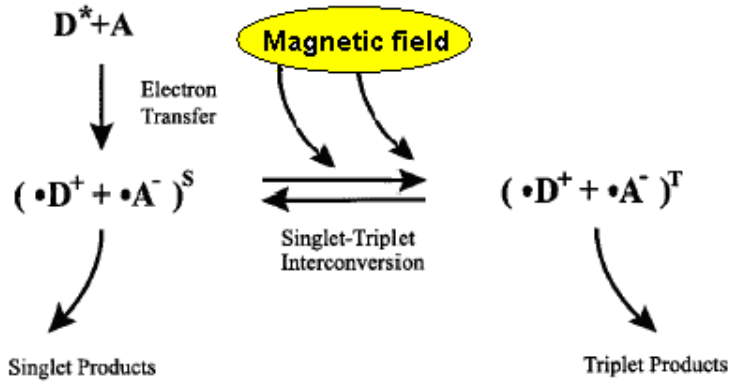
Figure 3. Reaction scheme for a radical pair reaction with magnetic field-dependent reaction products. The radical pair is generated by an electron transfer from a donor molecule D to an acceptor molecule A. An external magnetic field affects interconversion between singlet and triplet states of the radical pair. In these conditions, an applied weak magnetic field will result in an increased transient conversion of the radical pair into the triplet state, causing triplet products to be formed more rapidly and in higher yield ( S —singlet state of the radical pair, T —triplet state of the pair). (Reproduced from [32] by permission of the publisher, with minor